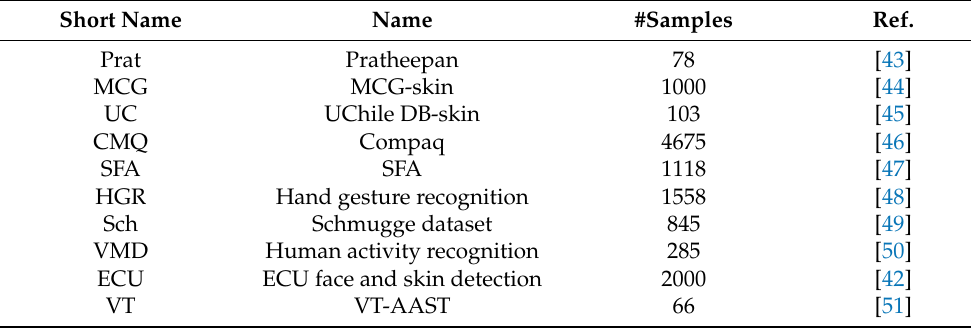
Table 1. Test skin datasets. ECU is split: 2000 images for training and 2000 for